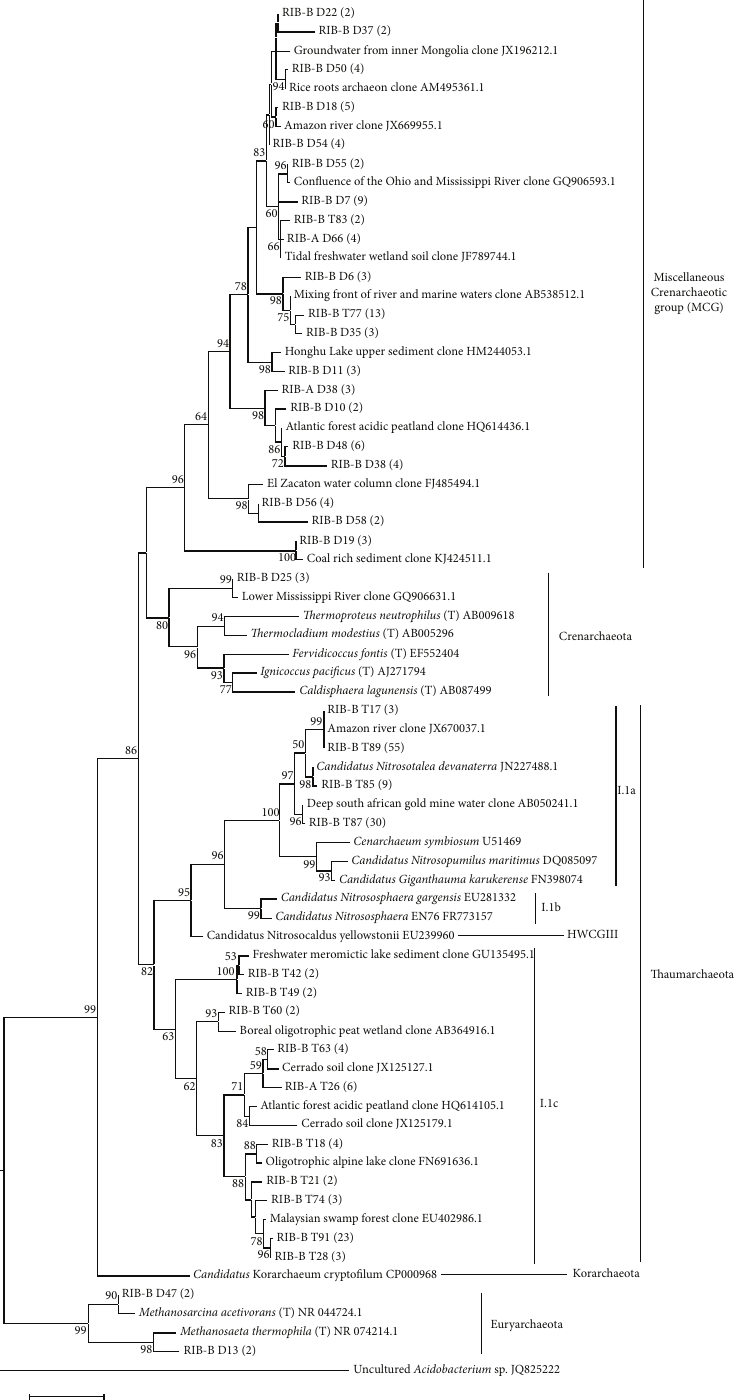
Figure 4: Phylogenetic tree of archaeal 16S rRNA gene OTUs (97%) obtained from Cerrado freshwater sediments in the dry season (RIB-A D and RIB-B D sequences) and in the dry to rainy season transition period (RIB-A T and RIB-B T sequences). The number of sequences that are represented by a specific node of the tree is indicated in parenthesis. The phylogenetic tree was inferred by the maximum-likelihood method using the MEGA software, bootstrap value of 1,000, and Tamura-Nei nucleotide substitution model. The percentage of bootstrap resamplings that supports each topological element is represented near the line. Reference sequences from different phyla were used for comparison and the bacterial sequence of the uncultured Acidobacterium sp. JQ825222 was used as an outgroup. Bootstrap values below 50 were not shown and singletons were not